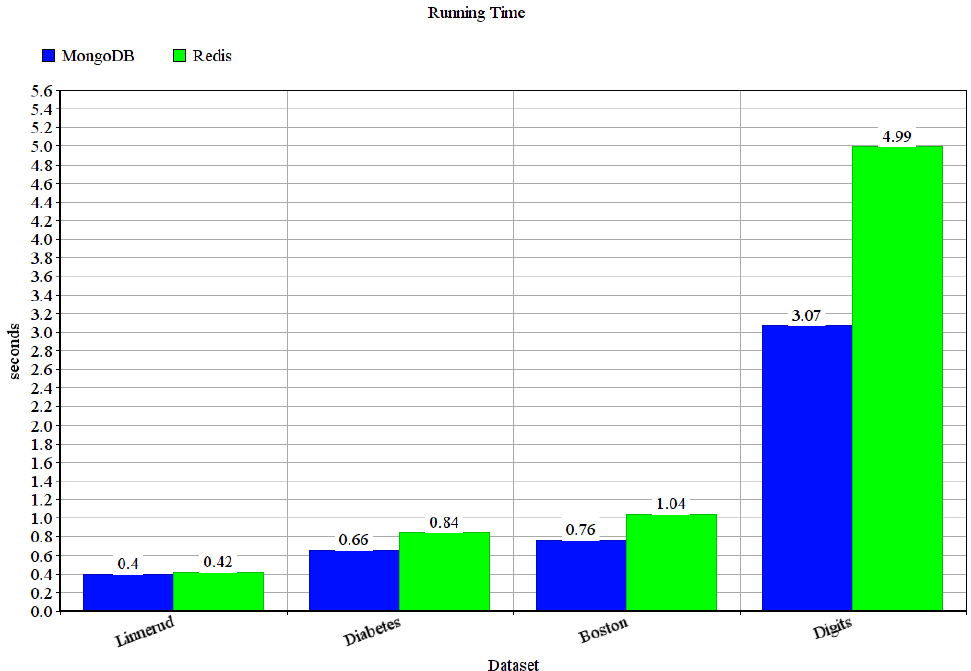
Figure 6. Running time in